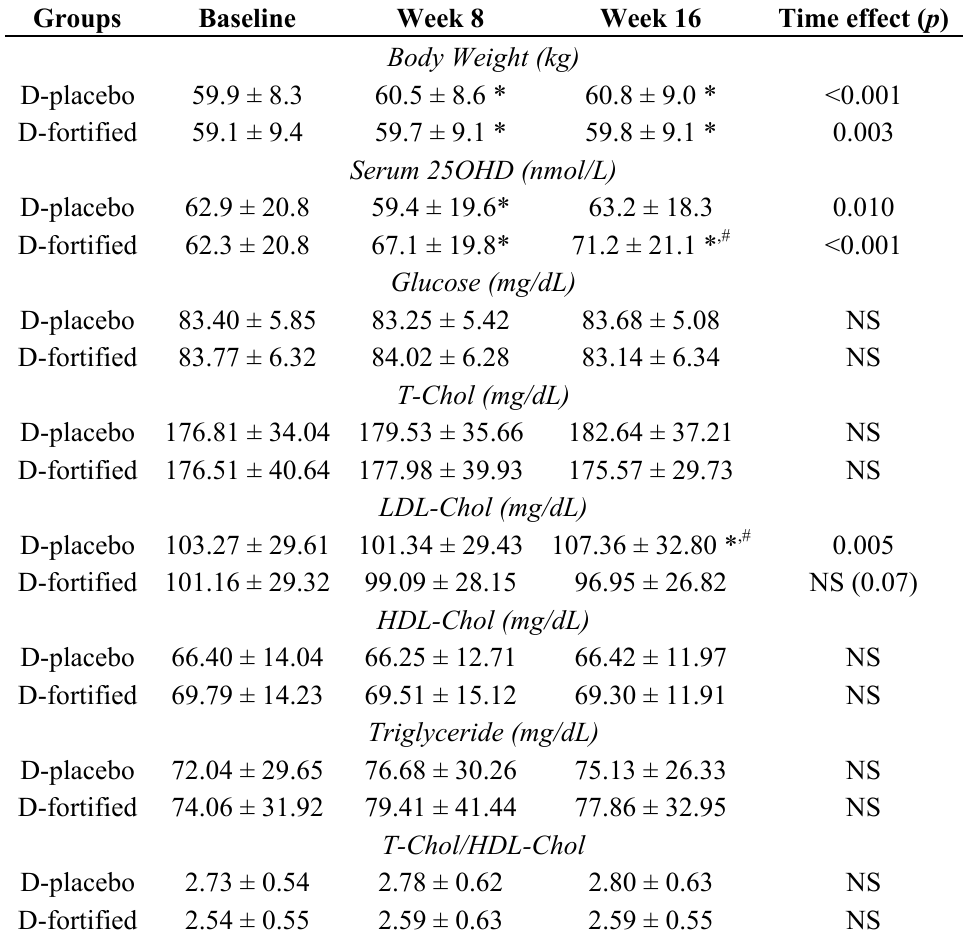
Table 3. Body weight, glucose, lipids and blood pressure of the intervention groups.